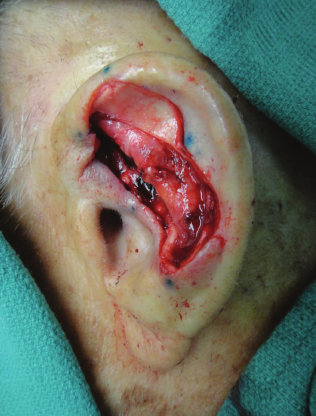
Figure 2: The final Mohs defect after two stages, measuring 4.6 × 2.4 cm.